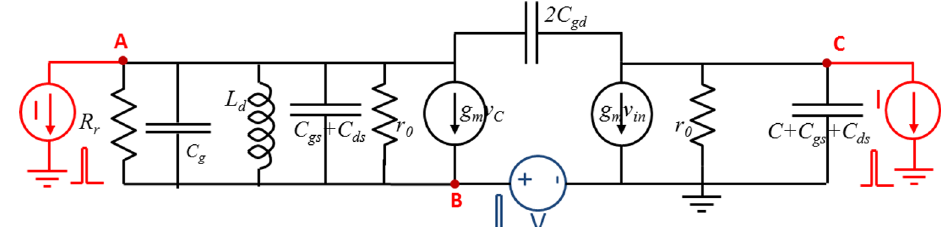
Fig. 13. Equivalent circuit of the gyrator NII coupled to the patch array (AMC). All three nodes and their respective impedance/ admittance analysis are represented.